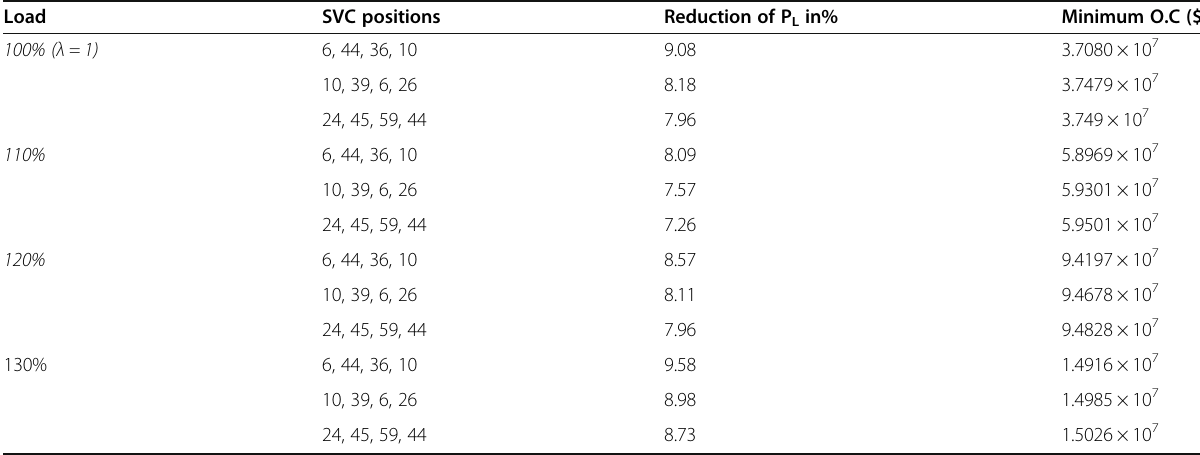
Table 9 Effect of SVC allocation on Indian 62-bus system at multi-load levels Load